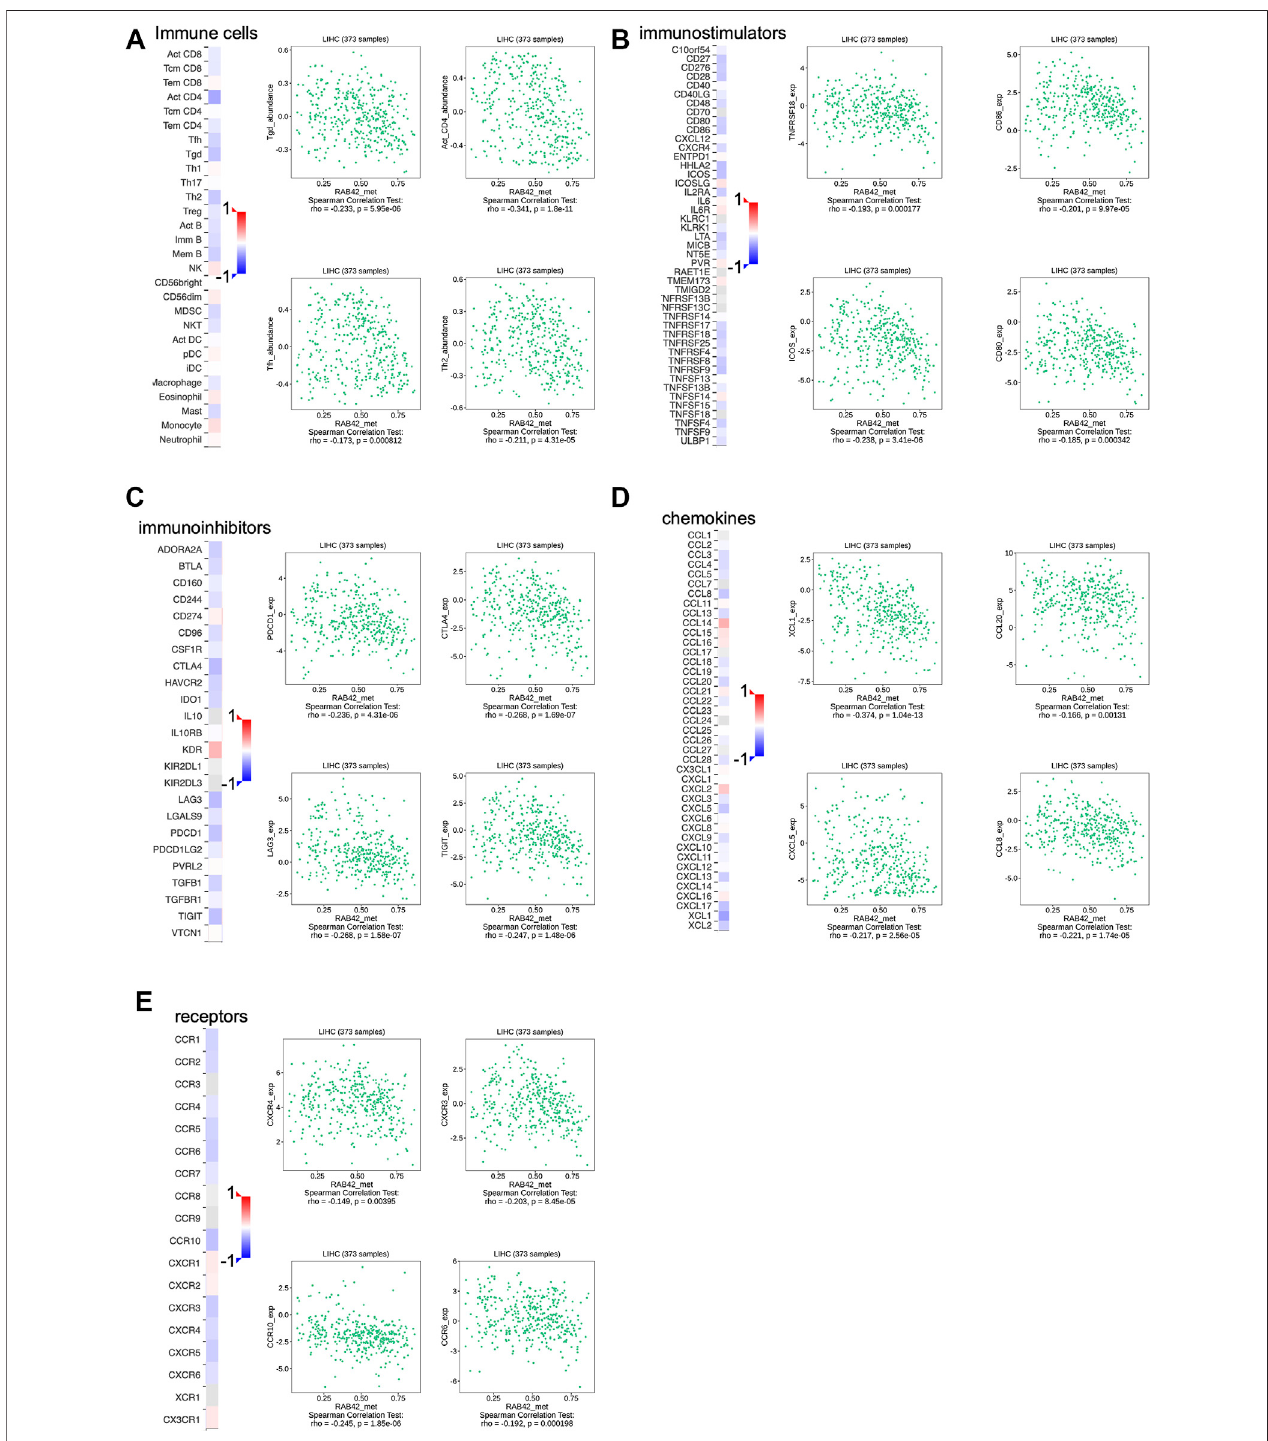
FIGURE 9 | Association between the methylation level of RAB42 with immune cells in fi ltration in HCC. (A) Heatmap showed the correlation of RAB42 methylation statuswithimmune-in fi ltratinglymphocytesinHCC.RAB42methylationstatuswasnegativelyassociatedwithgdThelpercells,ActivatedCD4 + T,Tfollicularhelpercells, andType2 ThelpercellsinHCCfromtheTISIDBdatabase.RAB42methylationstatuswasnegativelycorrelatedwithimmunecheckpointmolecules(TNFRSF18,CD86, ICOS, CD80) (B) , immunoinhibitors (PDCD1, CTLA4, LAG3, TIGIT) (C) , chemokines (XCL1, CCL20, CXCL5, CCL8) (D) and receptors (CXCR4, CXCR3, CCR10, CCR6) (E) in HCC from the TISIDB